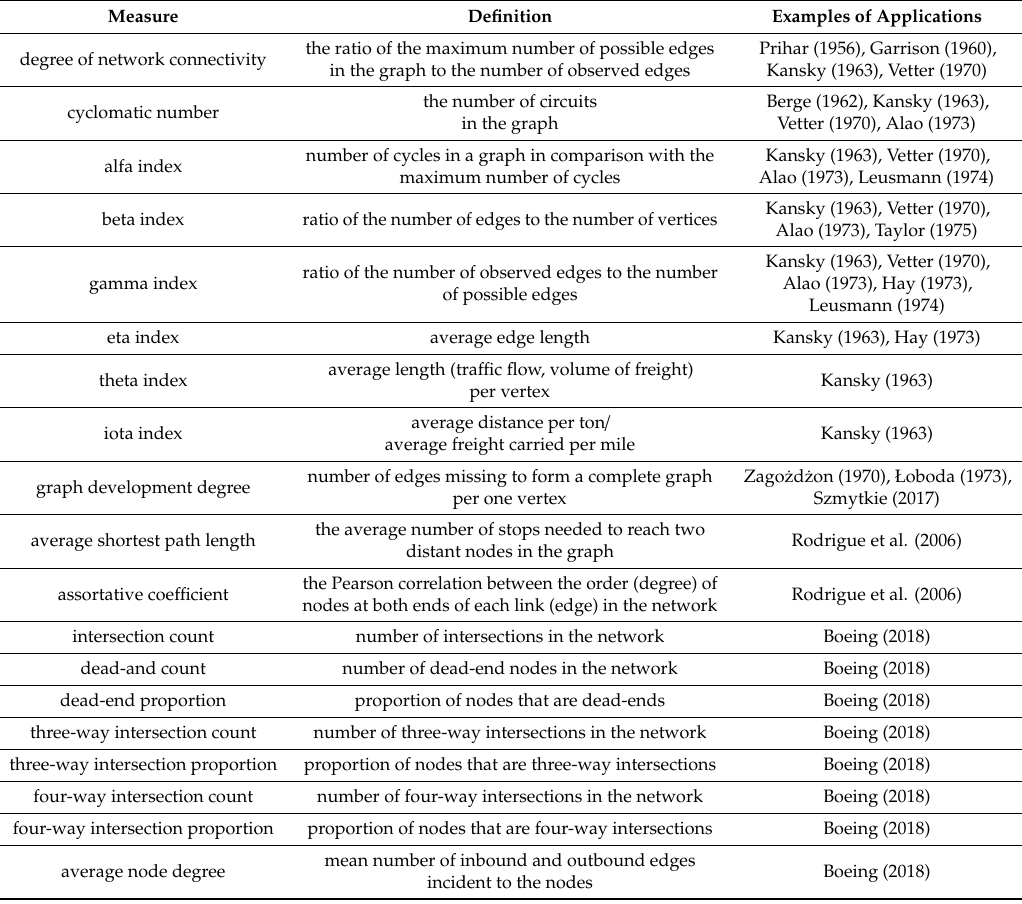
Table 1. Description of selected measures characterizing the connectivity of the planar